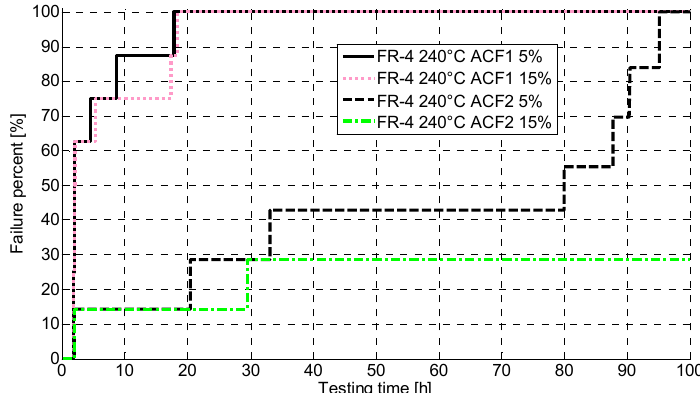
Figure 6. Cumulative distribution functions (CDFs) for FR ‐ 4 at 240 °C. ACF, Anisotropically conductive film.